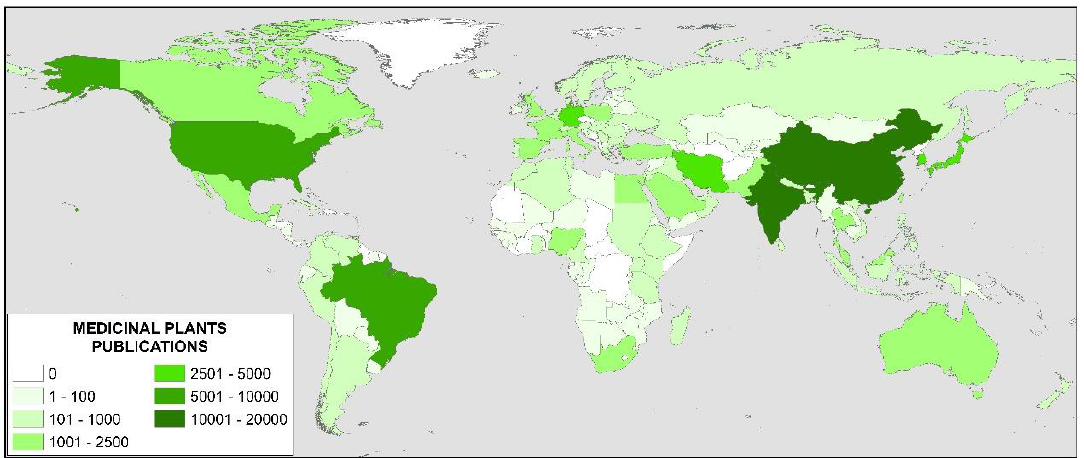
Figure 4. Worldwide research on medical plants.